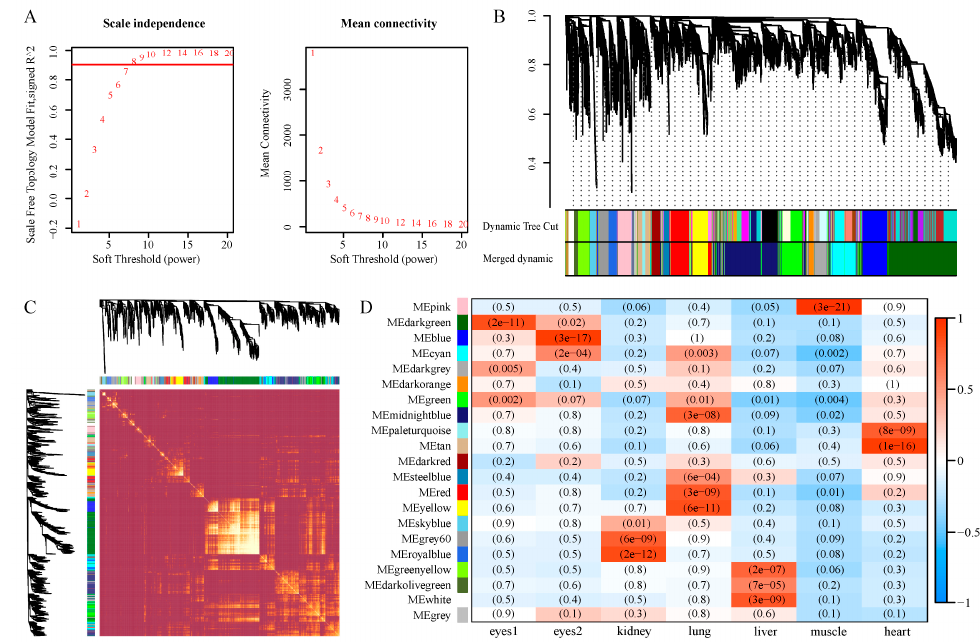
Figure 4. Co-expression analysis for orthologous genes from two snakes. ( A ) Analysis of soft-thresholding powers based on scale independence (left) and mean connectivity (right). ( B ) The cluster dendrogram of genes. Modules considered with high similarity were merged. ( C ) Network heatmap plots of all genes in WGCNA. ( D ) Heatmap of correlation between modules and traits. Shades of color represent correlation and the numbers in parentheses represent p -value .